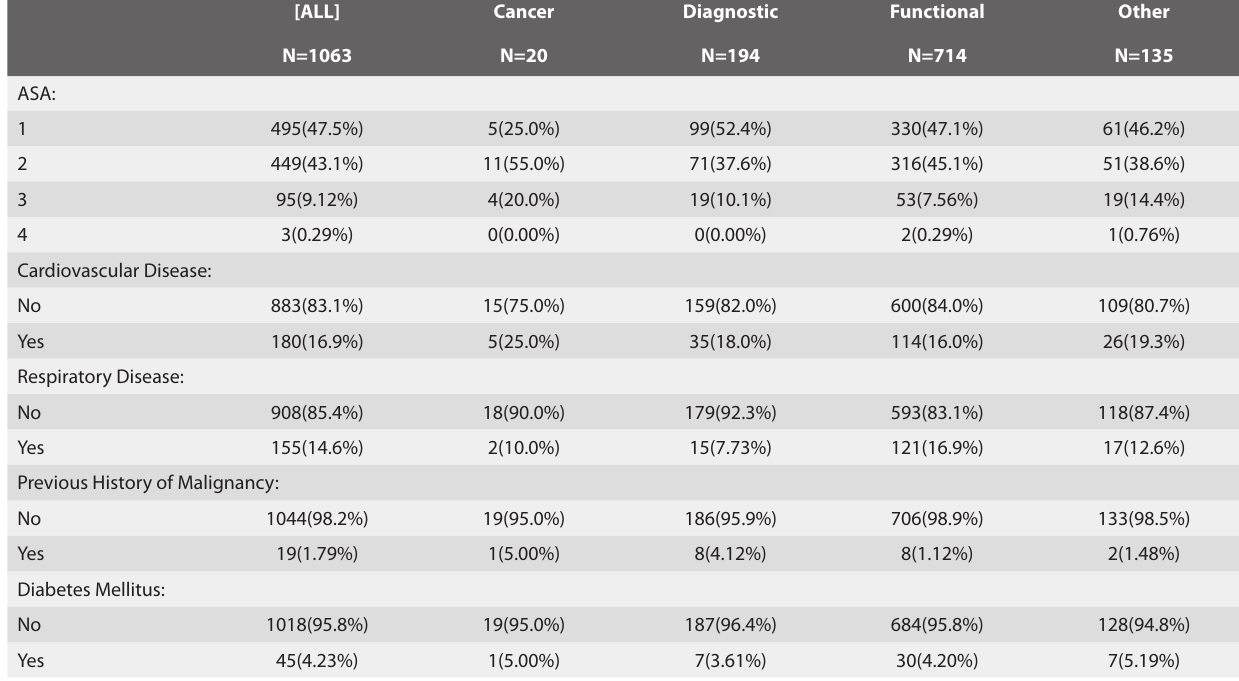
Table 2. Comorbidities.